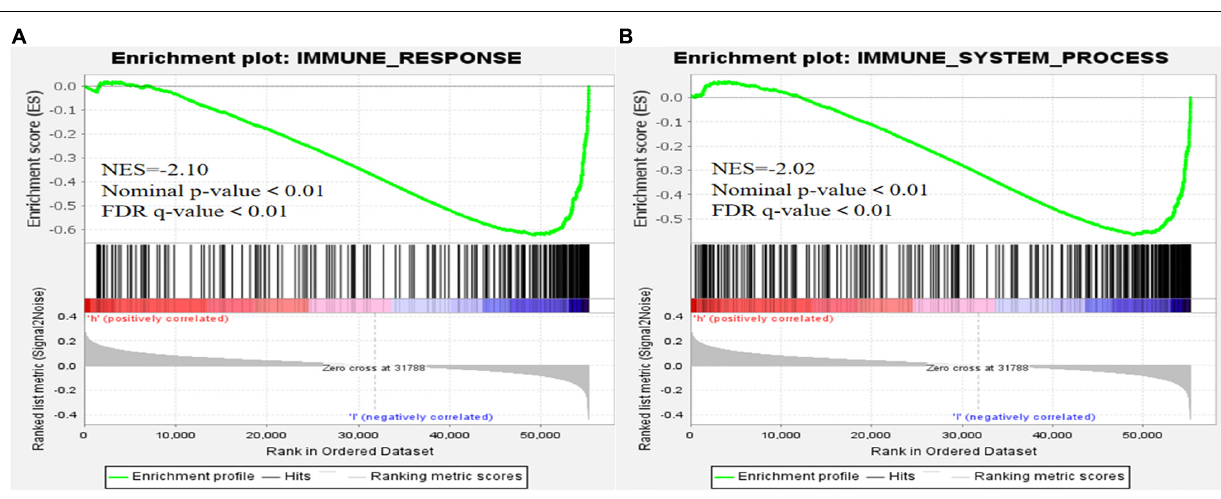
FIGURE 9 | Gene set enrichment analysis. (A) Immune response. (B) Immune system process (all P < 0.05; false discovery rate, <